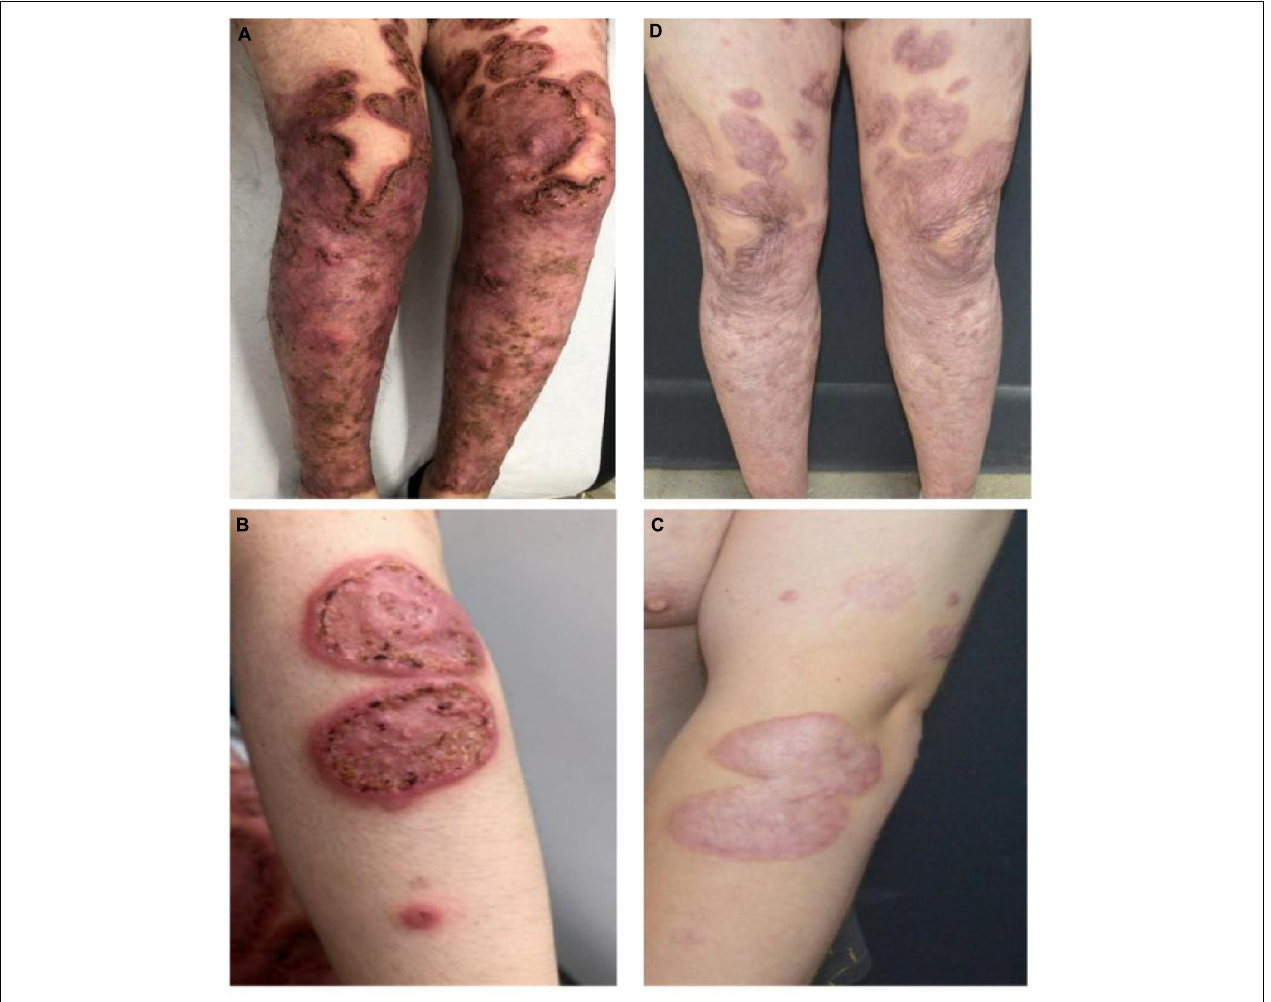
FIGURE 2 | Pyoderma gangrenosum before (A,B) and following combination therapy (C,D) , the healed ulcer formed atrophic cribriform